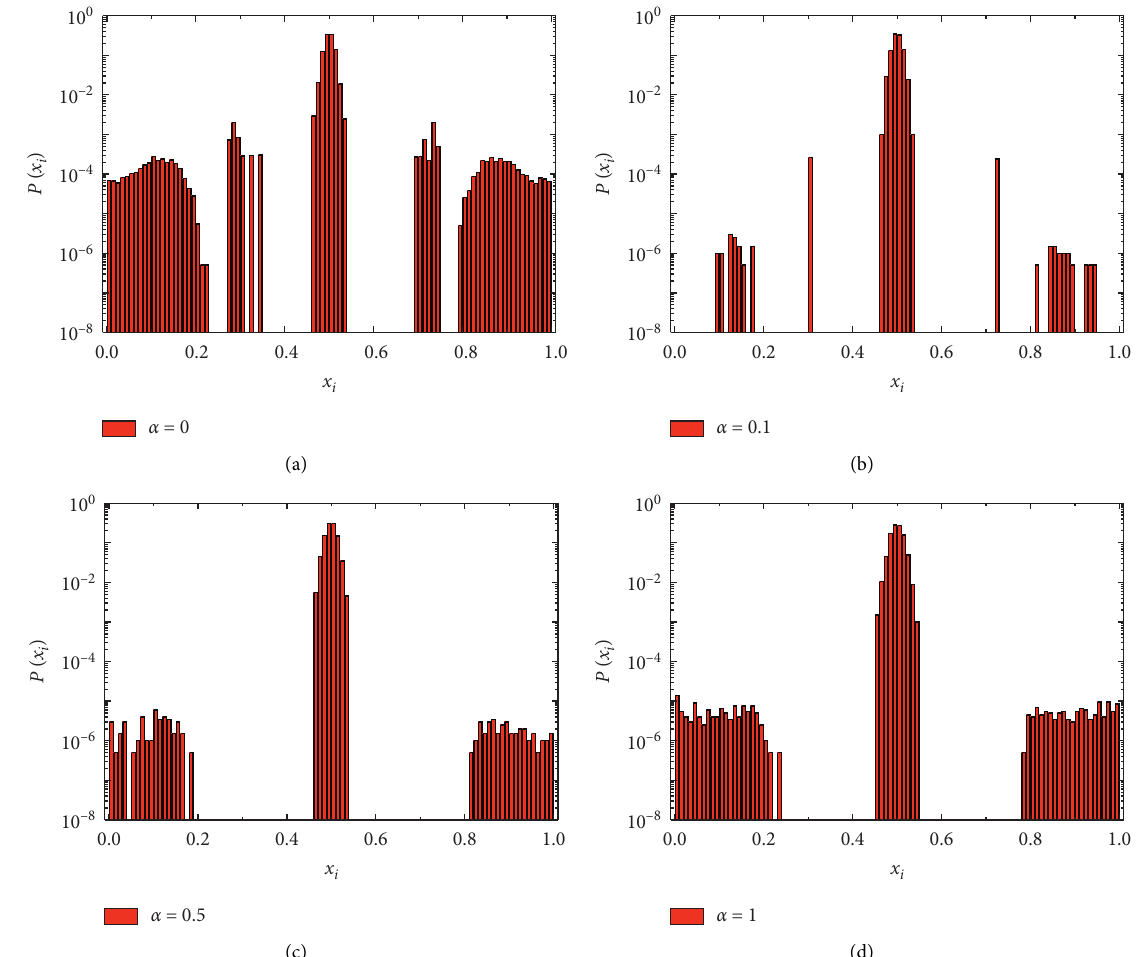
Figure 5: The distribution of opinions in the population P ( x